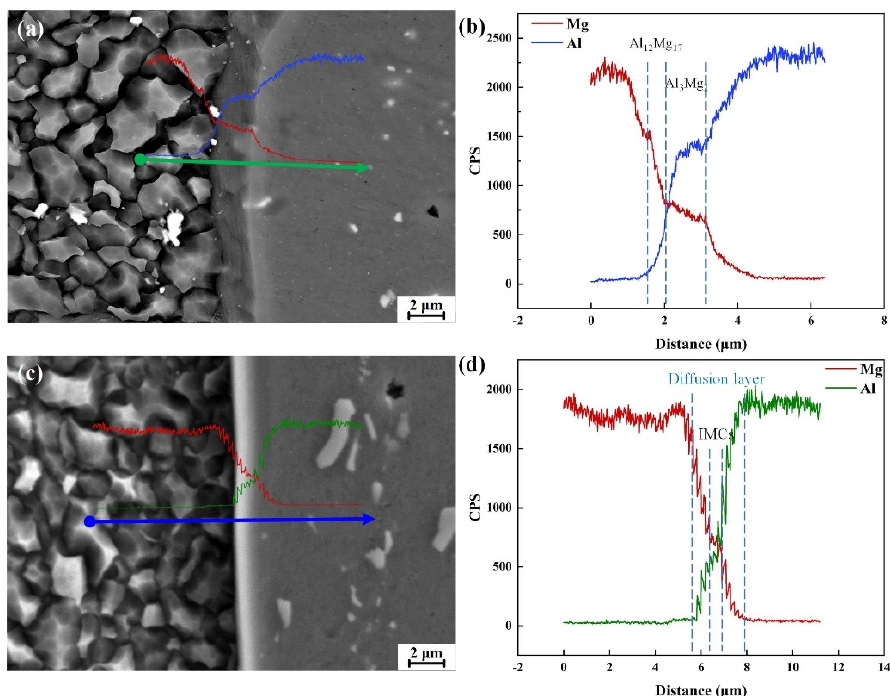
Figure 6. SEM and EDS results of the interface between Al and Mg in the ( a , b ) FSW and ( c , d ) SFSW weld fabricated at 800 rpm.